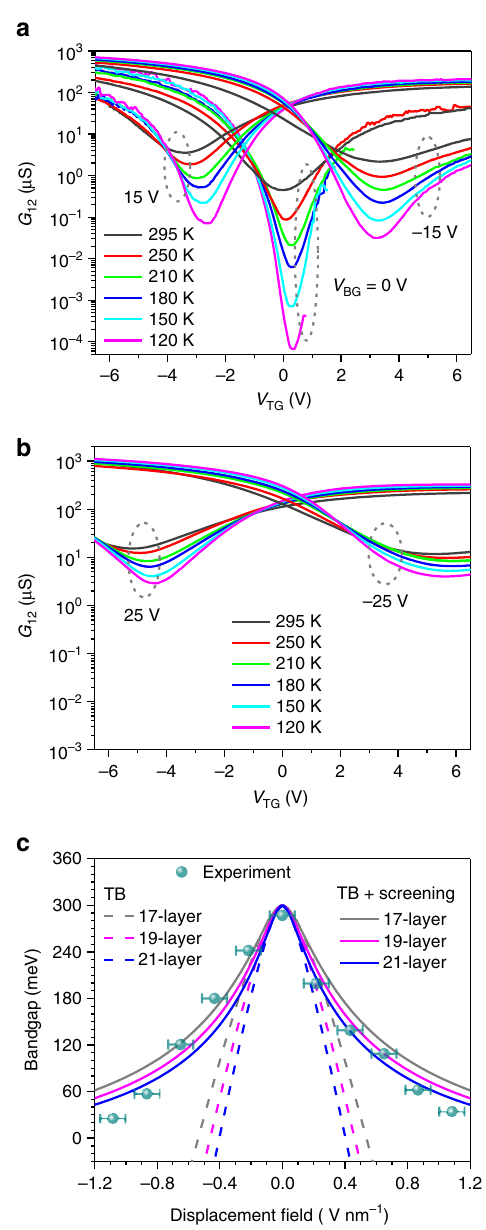
Figure 4 | Bandgap determination in 10nm-thick BP using temperature- dependent measurements. ( a ) The conductance of the 10nm-thick BP film as a function of top gate bias ( V TG ) at different temperatures from 120 to 295K. The curves at three different back gate biases are plotted ( V BG ¼ 0, (cid:2) 15 and 15V). The bandgap is measured through the temperature-dependent minimum conductivity at the charge-neutrality point. ( b ) Conductance measurement curves similar to those in a at two different back gate biases ( V BG ¼ (cid:2) 25 and 25V). ( c ) Dash (solid) lines: the calculated bandgap tuning properties for BP films consisting of 17, 19 and 21 layers using the tight-binding (TB) model without (with) additional bandgap-dependent dielectric screening effect. Dark cyan dots: the measured bandgap tuning for a 10nm-thick BP film ( B 19 layers). The error bars show the s.d., which accounts for the uncertainty in determination of displacement field due to the minor shift of V TM at different